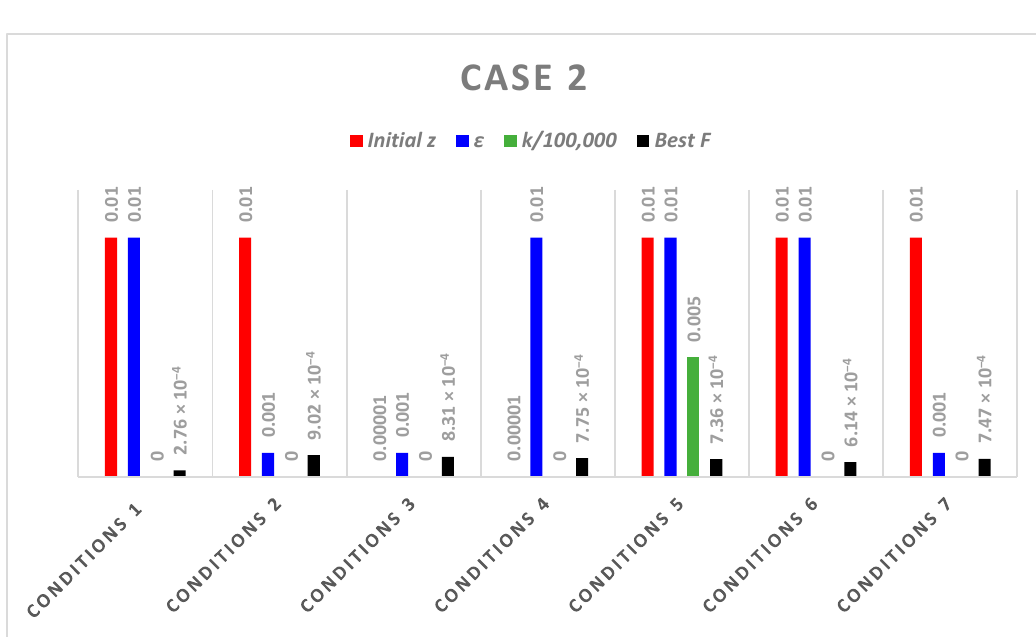
Figure 6. Graphical presentation of Table 5.